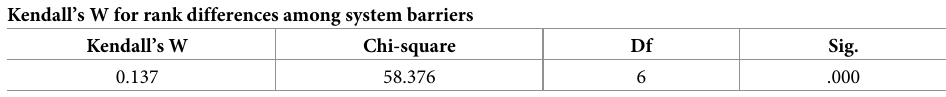
Table 7. Descriptive statistics (system-level barriers).